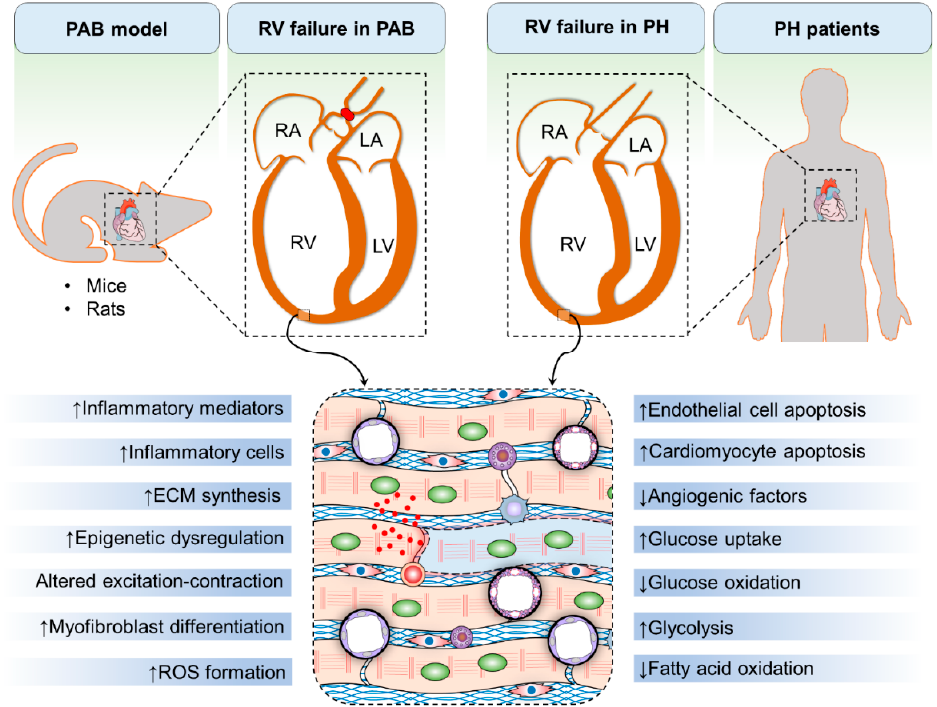
Figure 2. The pulmonary artery banding (PAB) model of right ventricular (RV) failure recapitulates many features of RV failure observed in pulmonary hypertension (PH) patients. PAB in mice and rats causes RV dilatation and RV wall hypertrophy similar to those observed in PH patients. Many of the pathological characteristics of RV remodeling in PH patients can be seen in the RV of PAB rodents, including increased myocardial inflammation, upregulation of inflammatory mediators, accumulation of extracellular matrix (ECM), myofibroblast differentiation, alterations of epigenetic processes, dysregulation of cardiomyocyte excitation–contraction coupling, oxidative stress, apop- tosis of cardiomyocytes and endothelial cells, downregulation of proangiogenic factors, increased glucose uptake and glycolysis, and decreased glucose and fatty acid